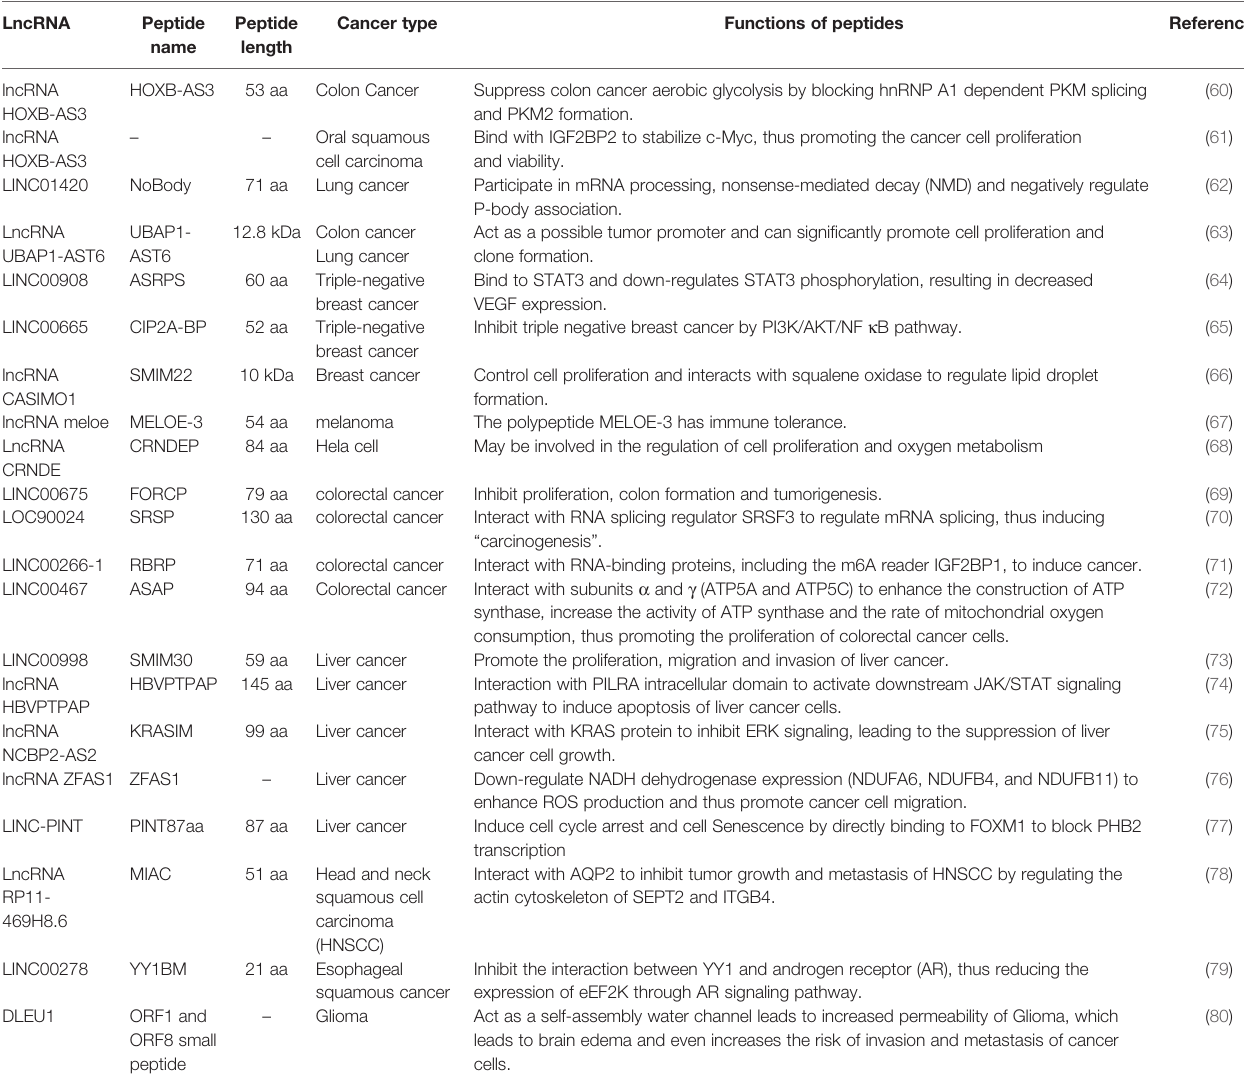
TABLE 1 | Tumor-related functional peptides encoding by